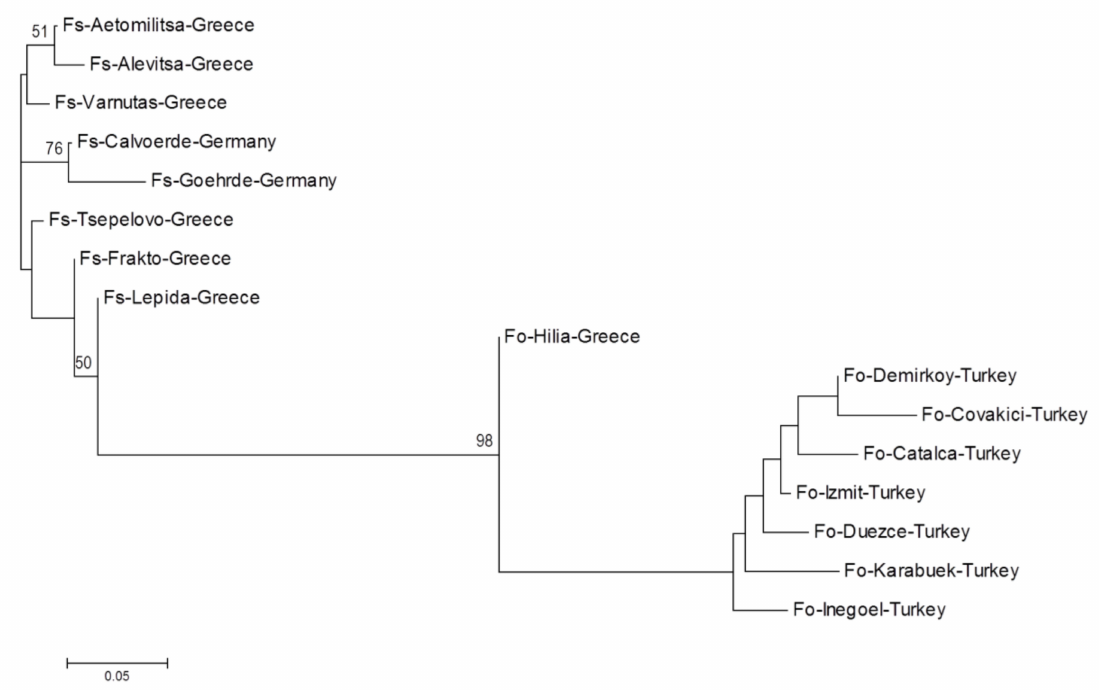
Figure 3. Neighbor-joining (NJ) dendrogram for all populations. Bootstrap values ≥ 50 are shown.